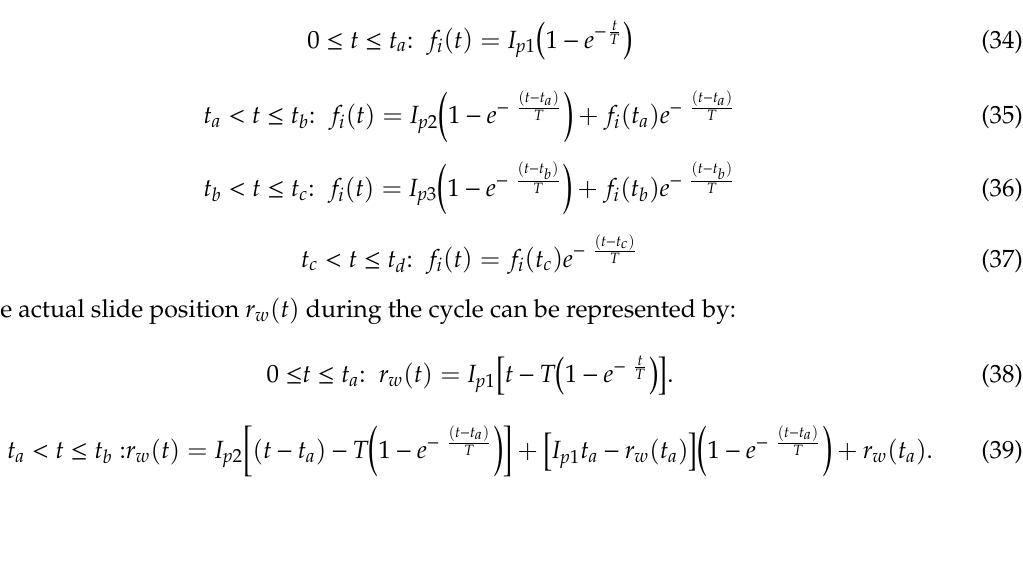
Figure 14. Setup of infeed grinding cycle.